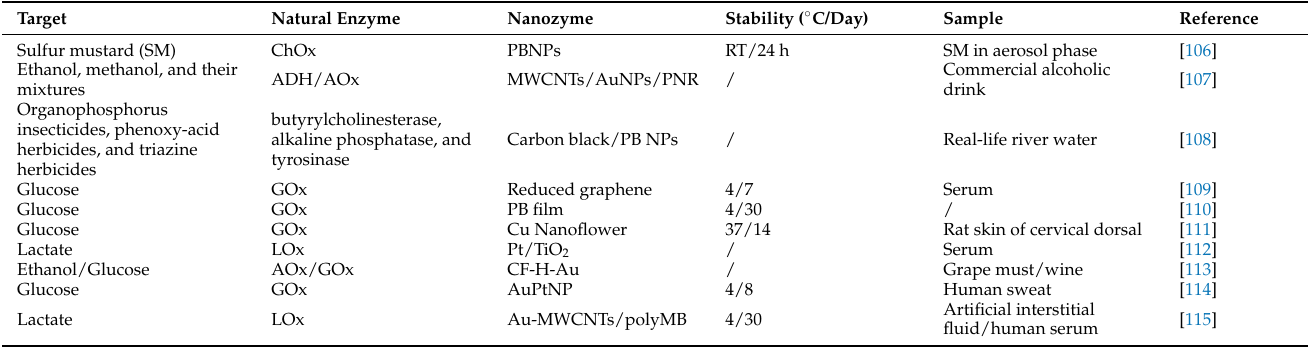
Table 4. Summary of the amperometric sensors combining natural enzymes with